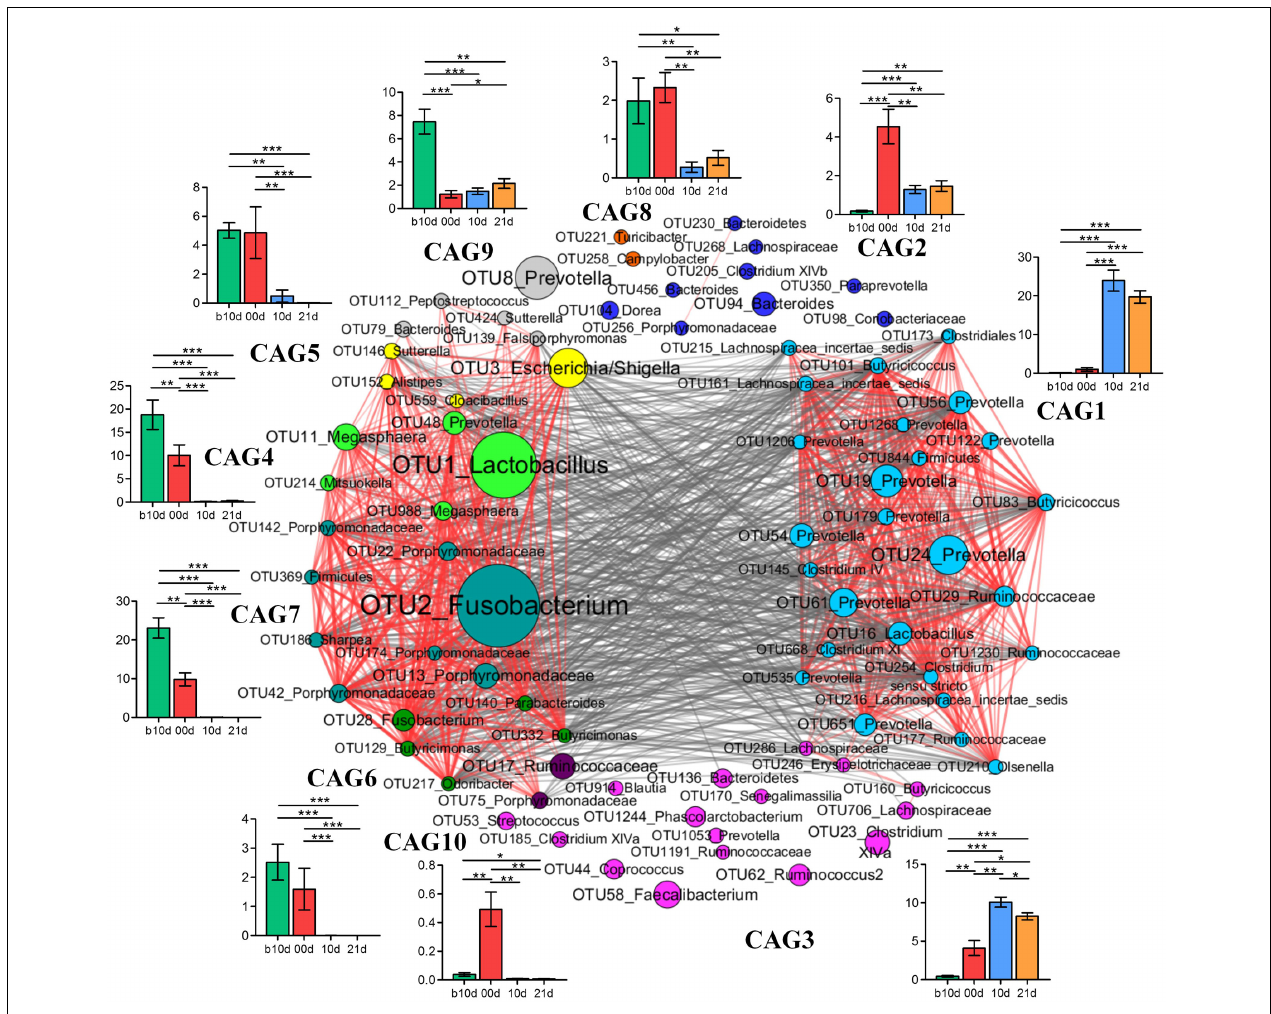
FIGURE 7 | Co-variation in the gut microbiota of piglets during the weaning transition. OTU-level network diagram of 82 key OTUs responding to age. Node size indicates the mean abundance of each OTU. Lines between nodes represent correlations between the nodes they connect, the color saturation and line width indicating correlation magnitude: red represents positive correlation, gray represents negative correlation. Only lines corresponding to correlations with a magnitude greater than 0.5 are drawn. The OTUs are grouped into 10 CAGs by permutational multivariate analysis of variance (PERMANOVA) when P < 0.01. The plots show the abundance of each CAG on b10d, 00d, 10d, and 21d. Data in plots represent the total abundance of all OTUs in each CAG from each sample, which were then visualized by mean ± SEM. Paired sample Wilcoxon signed-rank test was used to analyze variations between two different time points. ∗ P < 0.05, ∗∗ P < 0.01, ∗∗∗ P < 0.001 (with FDR